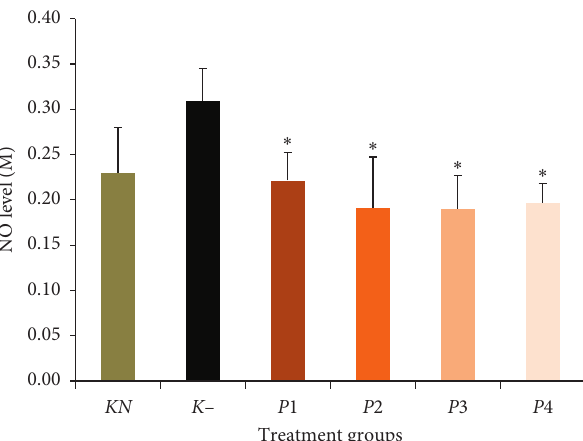
Figure 2: Effect of methanol extract of okra pods on nitric oxide (NO) level in lead acetate-induced mice. Values are as expressed as mean ± standard deviation ( n � 5). ∗ P < 0 . 05 shows significant differences in K − , confidence interval 95%. KN : normal control, K − : negative control. P 1, P 2, P 3, and P 4 were treated with 50, 100, 200, and 400mg/kg BW methanol extract of okra pods, respectively.